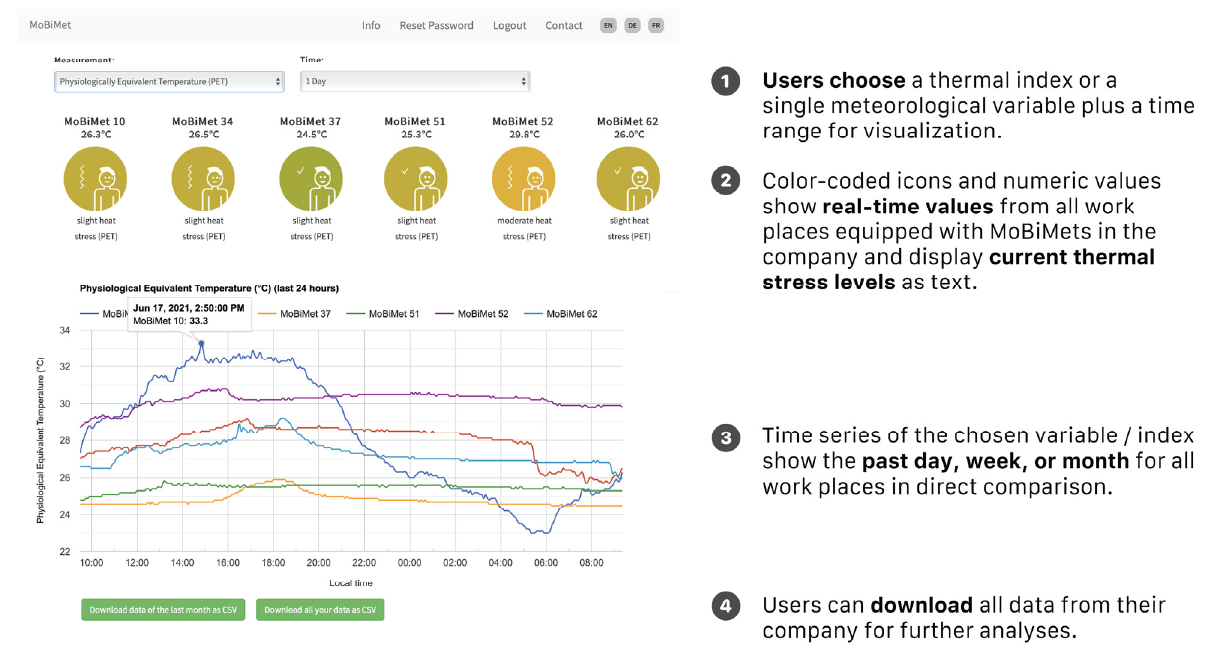
Figure 2. Layout of the MoBiMet